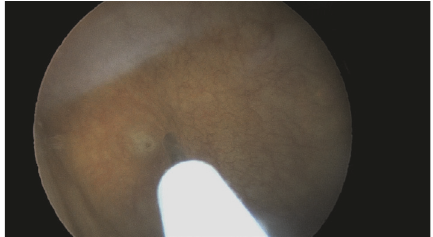
Figure 5: Needle removed completely with no bleeding noted from injection site.